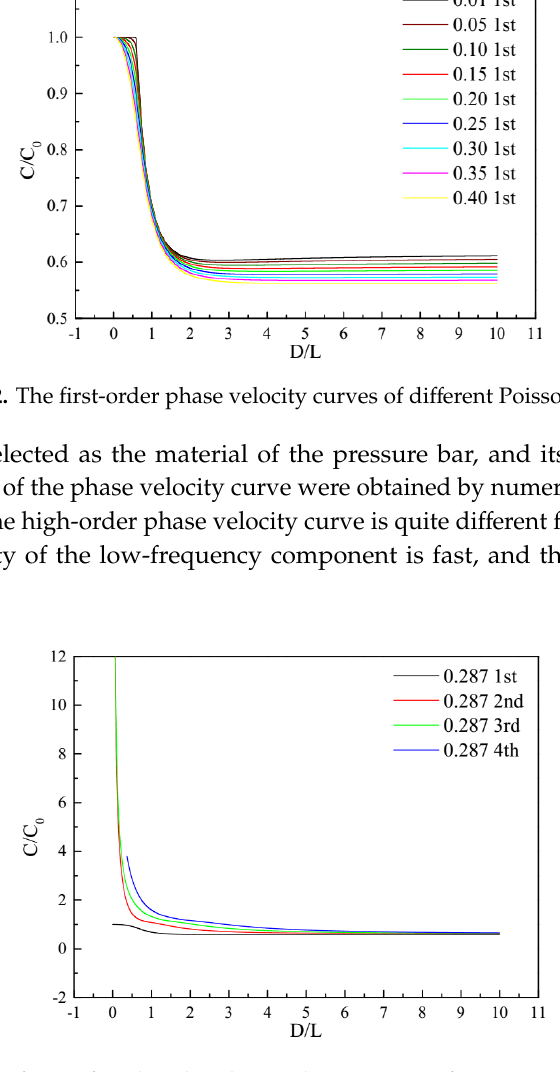
Figure 1. The sign and discontinuous point distribution of the real part of the function value ( 0.3  ).